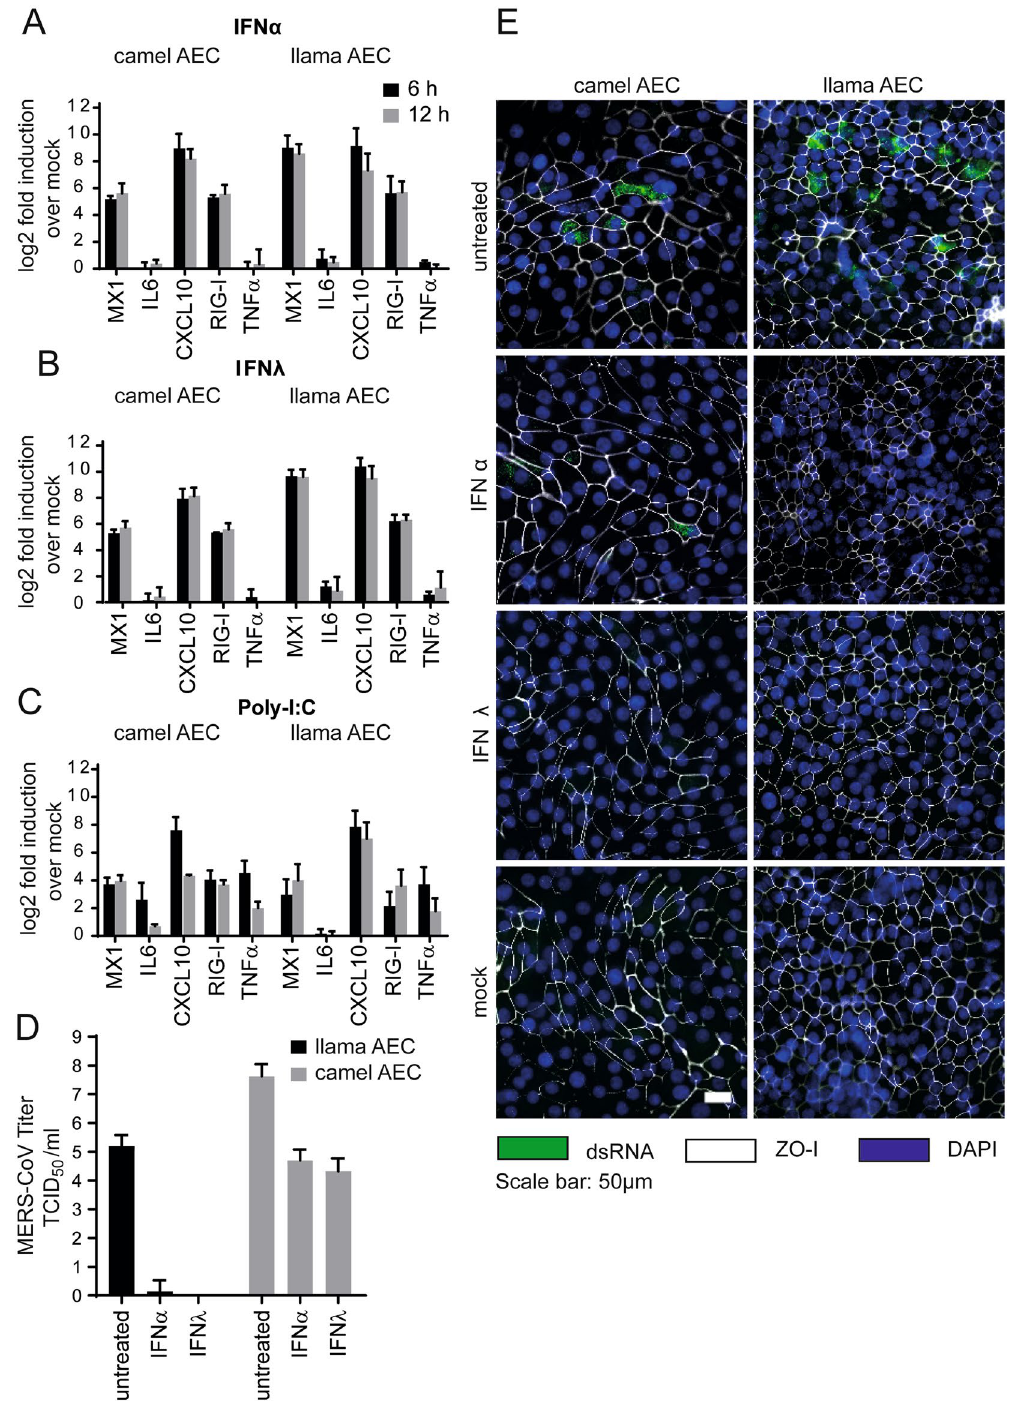
Figure 3. IFN treatment efficiently induces innate immune response and reduces MERS-CoV replication in camelid AEC cultures. MX1, Interleukin-6 (IL6), CXCL10, RIG-I and TNF-α expression in log 2 fold induction over mock in camel and llama AEC cultures is displayed 6- and 12-h post-stimulation with type I IFN ( A ), type III IFN ( B ), and poly I:C ( C ) treatment. ( D ) MERS-CoV titers in TCID 50 /ml released from camelid AEC cultures’ apical side 48 h post-infection in presence and absence of type I and III IFN pretreatment. Data is shown as means and standard deviation from three independent biological replicates. ( E ) Representative immunofluorescence staining of type I and III IFN pretreated camelid AEC cultures at 48 h post- infection. Double-stranded RNA is shown in green, ZO-I in white and DAPI in blue. Scale bar is 50